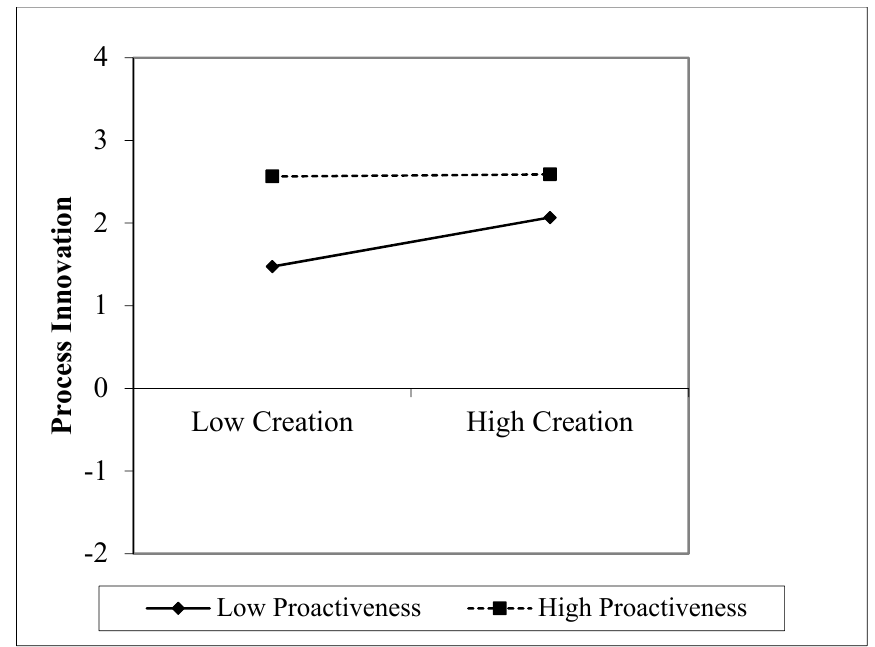
Figure 2. The moderating effect of proactiveness on the knowledge creation–process innovation relationship. Source: Own elaboration.